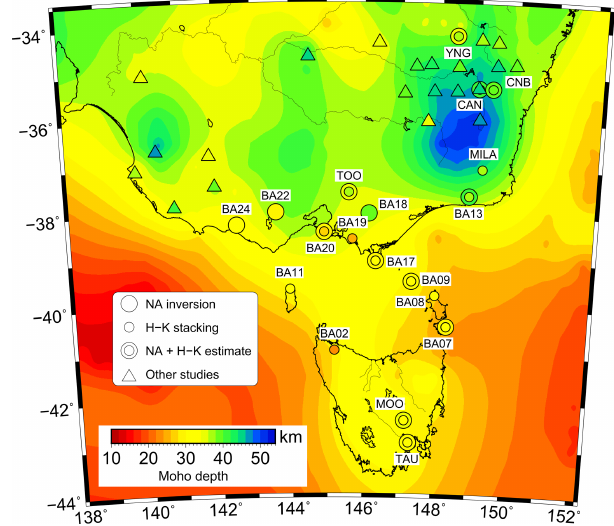
Figure 11. Comparison between the AusMoho model (background colour map) and the Moho depths determined through RF analysis in this and previous studies. Small coloured circles denote the Moho depths determined from H – κ stacking, whereas large coloured cir- cles correspond to receiver function estimates. When both H – κ - and NA-derived depths are available at a single station, the smaller H – κ circle is superimposed on the larger NA circle so that both depths can be observed on the one plot. Moho depths determined from previous RF studies are denoted by